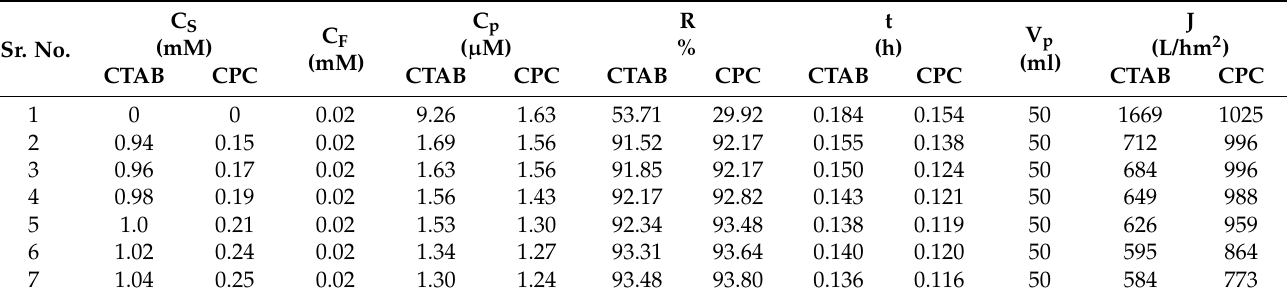
Figure 4. Rejection percentage (R%) for the effect of ( a ) surfactant concentration (C S ), ( b ) electrolyte concentration (NaCl), ( c ) transmembrane pressure, ( d ) RPM using ( e ) pH. Table 3. Rejection coefficient, R%, and permeate flux, J, of Naphthol Green B for different surfactant concentrations, C s , at fixed dye concentration, C F , dye concentration in permeate solution, C p , filtration time, t, permeate volume, V p.